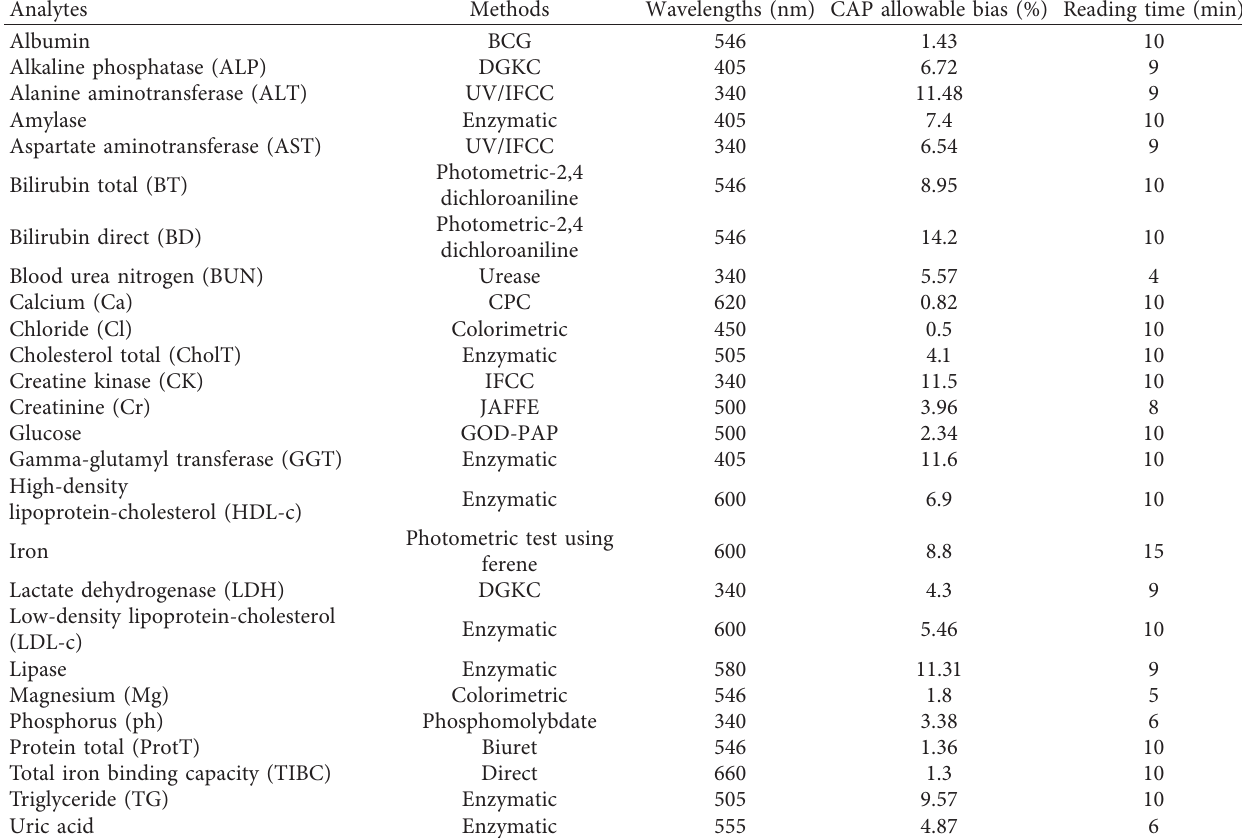
Table 1: Chemical methods, wavelengths, and the CAP allowable